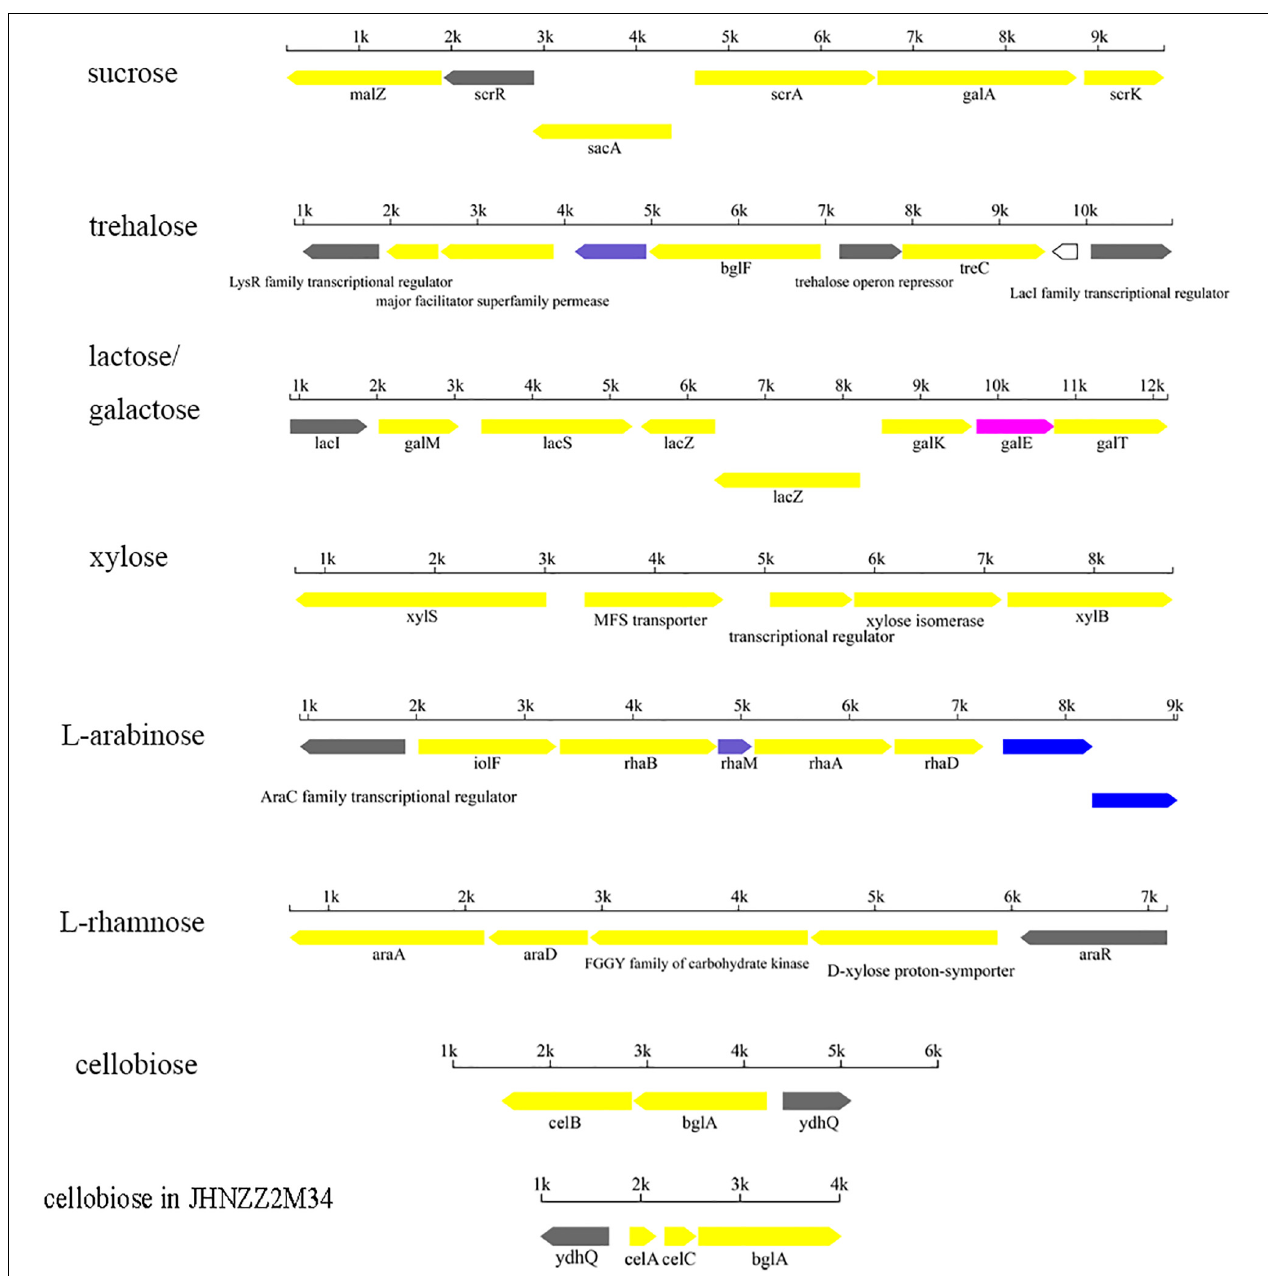
FIGURE 10 | Putative operons for the predicted utilization of carbohydrates in P.